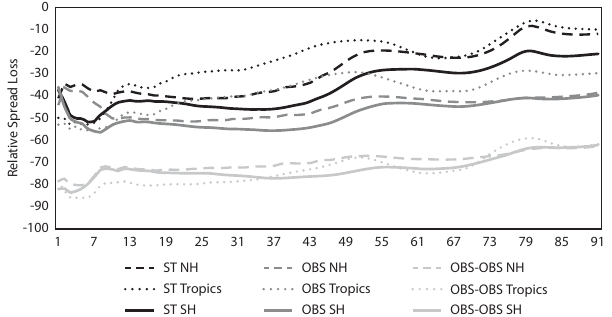
Figure 5. Zonal wind field relative average spread loss of OBS , ST , OBS-OBS EDA with respect to XB EDA at every model level and for Northern (dashed line) and Southern (solid line) Hemisphere and tropics (dotted